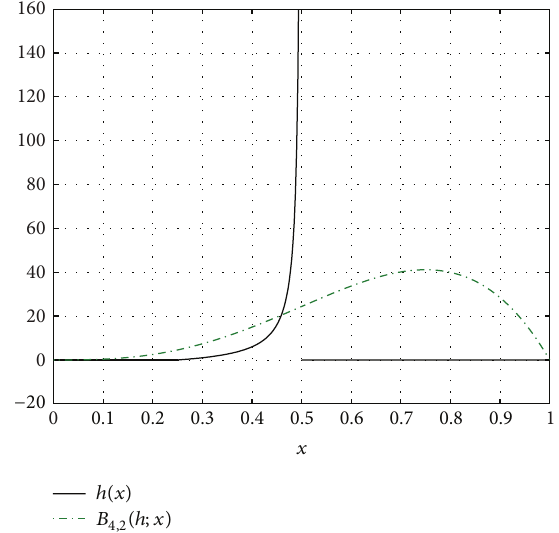
Figure 3: Graphs of 𝑦 = ℎ(𝑥) and 𝑦 = 𝐵 𝑛,2 (ℎ; 𝑥) , 𝑛 = 4 .